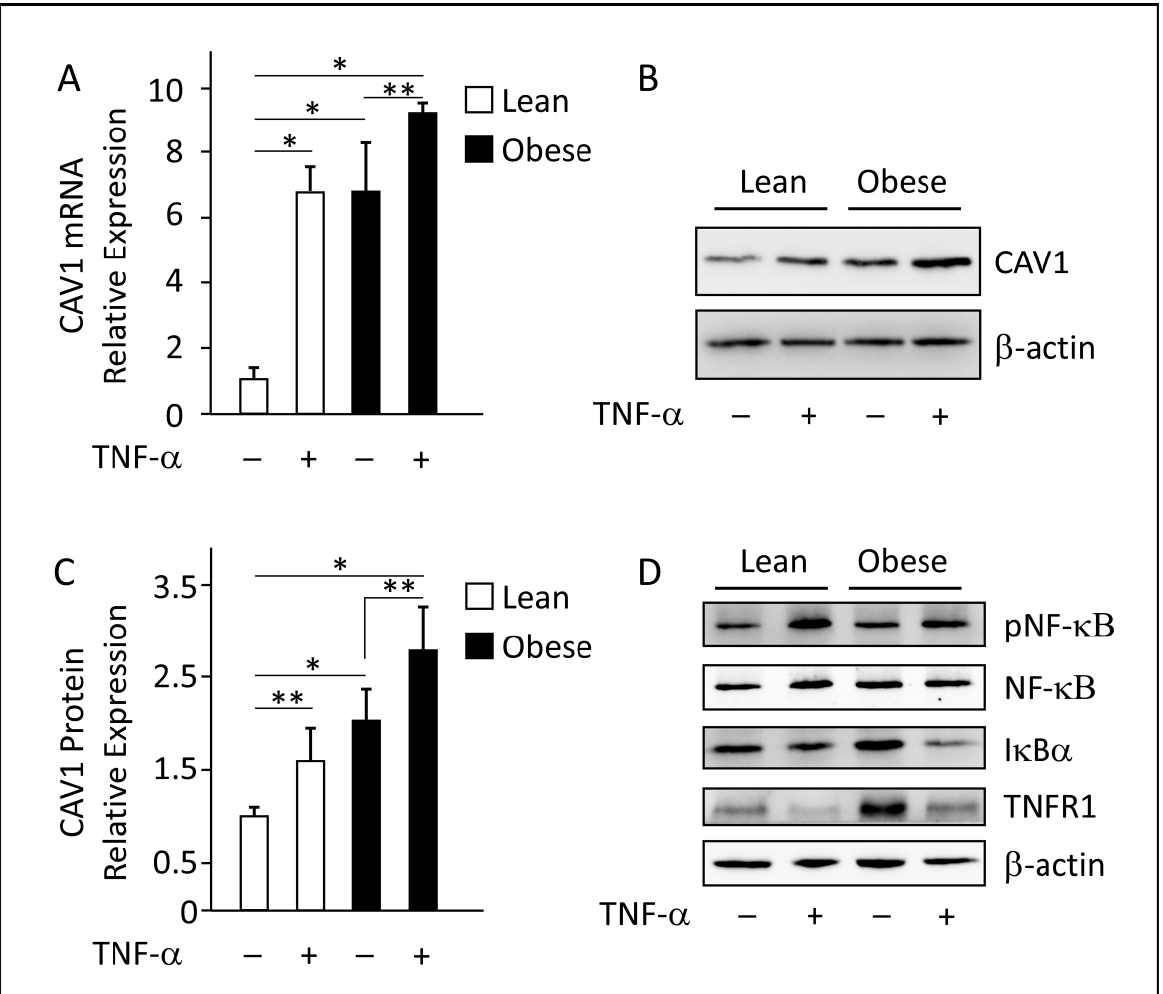
Figure 4. TNF- α augments the expression of CAV1 in differentiated adipocytes isolated from lean and obese individuals. ( A ). Relative to untreated lean adipocytes, CAV1 mRNA expression levels were significantly elevated in obese adipocytes, and in response to TNF- α treatment for 24 h. Data are presented as mean ± SEM values obtained from three independent experiments ( n = 3); a Two-tailed unpaired Student’s t -test was used to determine significance. ( B , C ). Western blots for total protein extracts (5 µ g) were developed with antibodies against CAV1 and β -actin, as indicated. CAV1 basal protein expression was significantly elevated in obese compared to lean adipocytes and was significantly induced in response to TNF- α treatments of both lean and obese adipocytes. A two-tailed unpaired Student’s t -test was used to determine significance ( n = 3). * p < 0.001; ** p < 0.05. ( D ). Treatment with TNF- α activates the NF- κ B signaling pathway in both lean and obese adipocytes. Western blots were developed with antibodies against phospho-NF- κ B, total NF- κ B, I κ B α , and the TNF- α receptor TNFR1. 24 h post-TNF- α treatment, NF- κ B was activated by phosphorylation and the degradation of its inhibiter I κ B α . Furthermore, TNFR1 was desensitized to TNF- α signaling post-24 h treatments (representative Western blots, n =